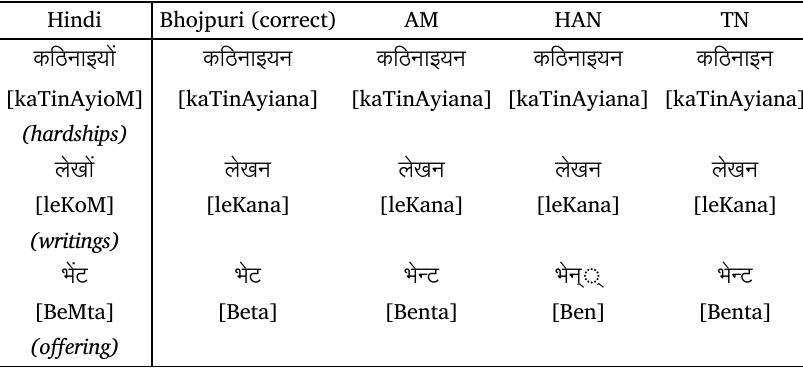
Table 8: Handling anusvāra Hindi